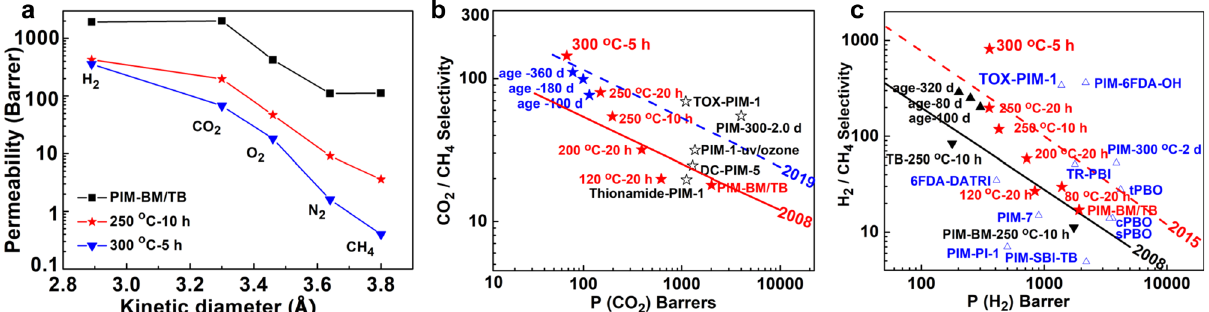
Fig. 6 Gas transport properties. a Gas permeabilities as a function of kinetic diameters. b CO 2 /CH 4 separation with Robeson upper bound. c H 2 /CH 4 separation with